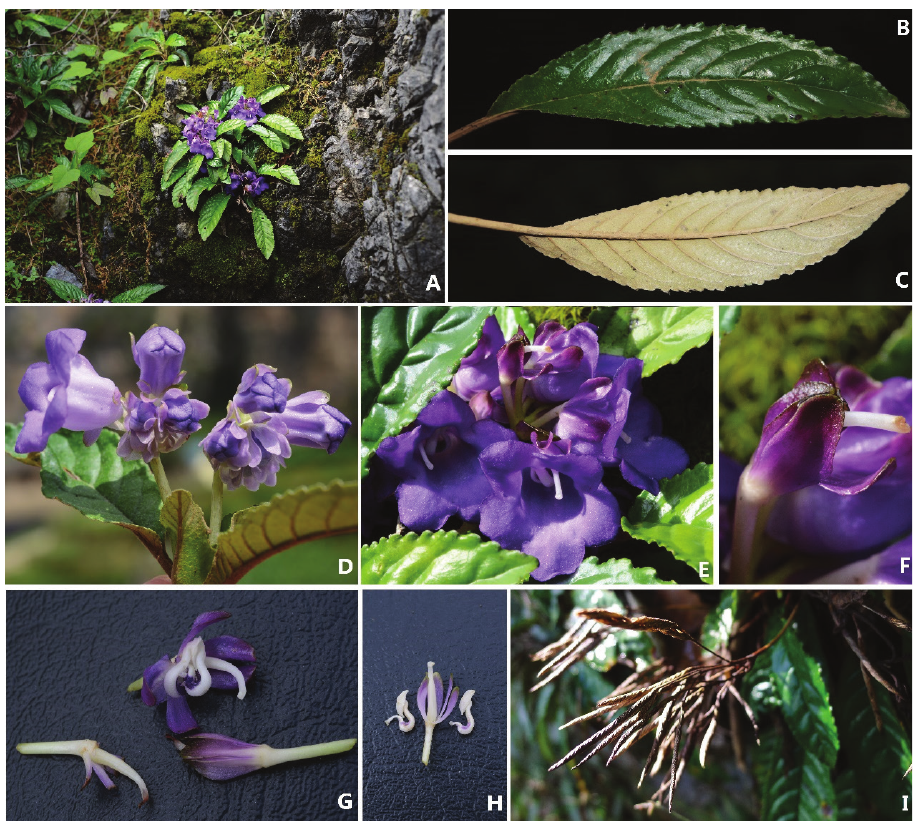
Figure 2. Paraboea wenshanensis X.Hong & F.Wen. A Habitat B Adaxial surface view of leaf blade C Abaxial surface view of leaf blade D Cyme with flowers, showing wide campanulate E Frontal view of corolla F Calyx lobes G Opened corolla for showing stamens and pistil H Pistil with calyx lobes and stamens, showing anthers and strongly geniculate filaments I Infructescence with many